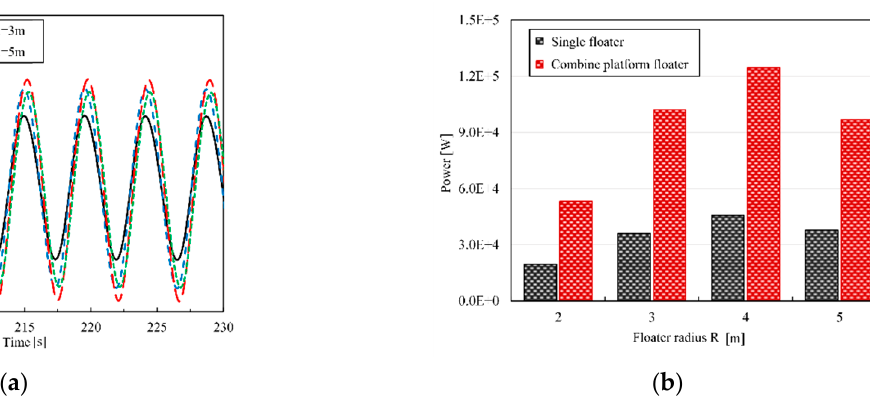
Figure 11. Comparison of velocity and power generation of floaters with different sizes under regular waves: ( a ) floater velocity comparison; ( b ) power comparison.